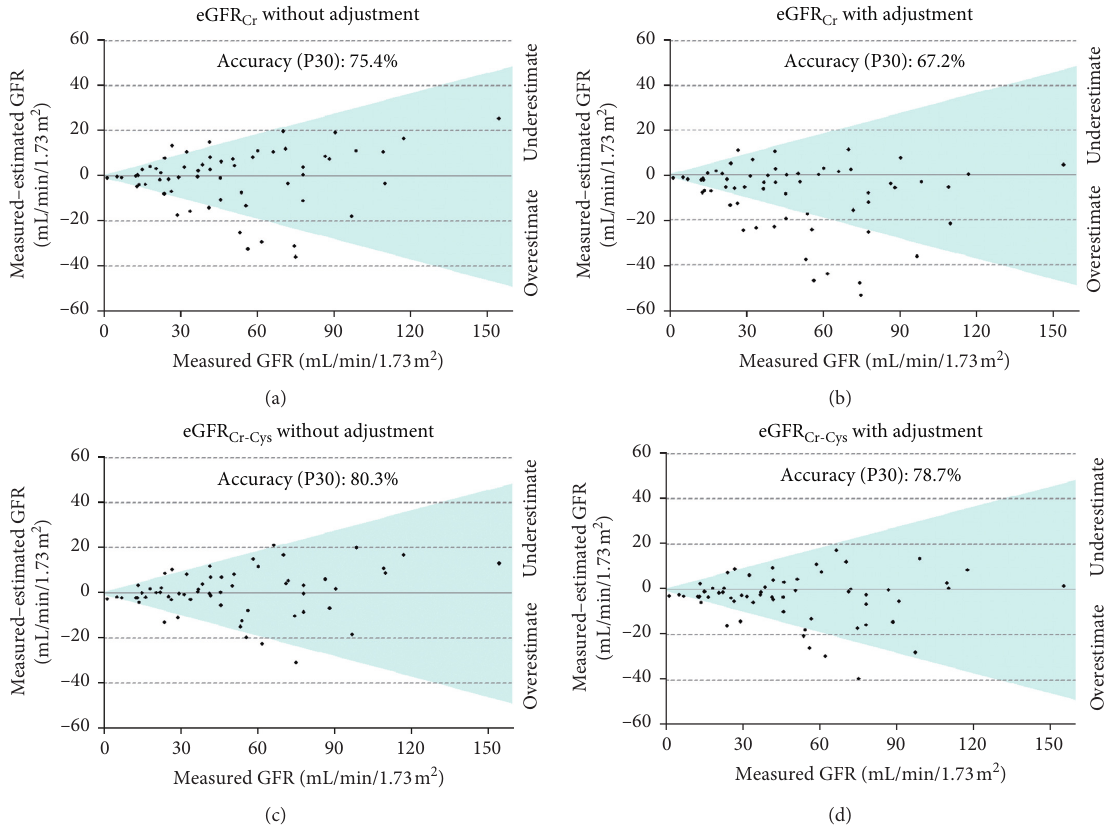
Figure 3: Accuracy of CKD-EPI equations for African Brazilians ( n � 61), where dots inside the colour area mean a difference between measured and estimated GFR lower than 30%